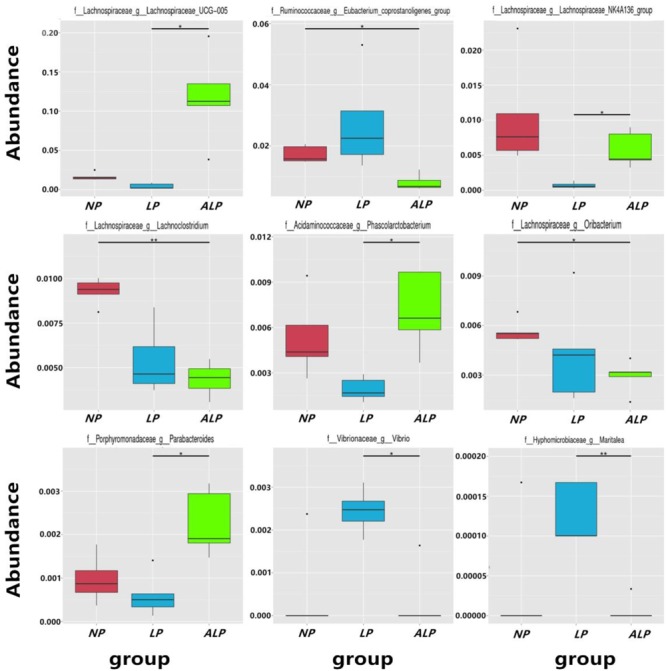
Relative abundance of microbial genera (percentage) in pig cecum that were significantly affected by dietary treatment. NP, normal protein; LP, low protein; ALP, AKG plus low protein. ∗Indicates significant difference between the two groups (q value < 0.05), ∗∗indicates the difference between the two groups was significant (q value < 0.01).